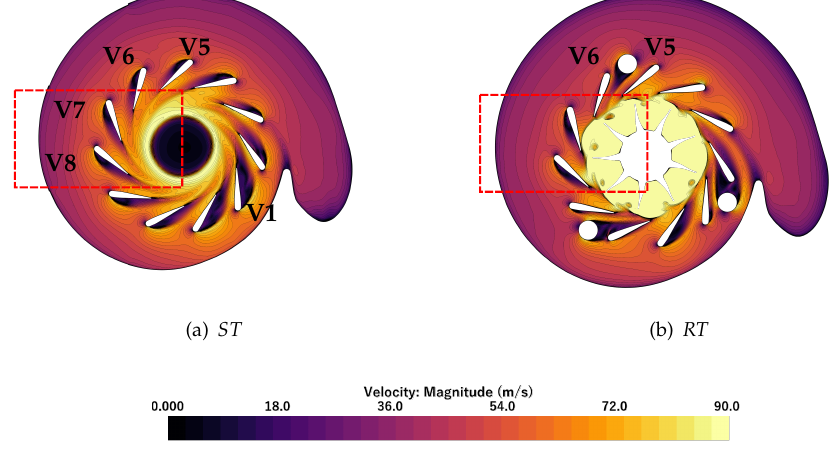
Figure 4. Global velocity distribution at stator midspan. ST and RT; VGT60; 0.5 mm tip Figure 4. Global Velocity distribution at stator midspan. ST & RT. VGT60. 0.5 mm tip height.